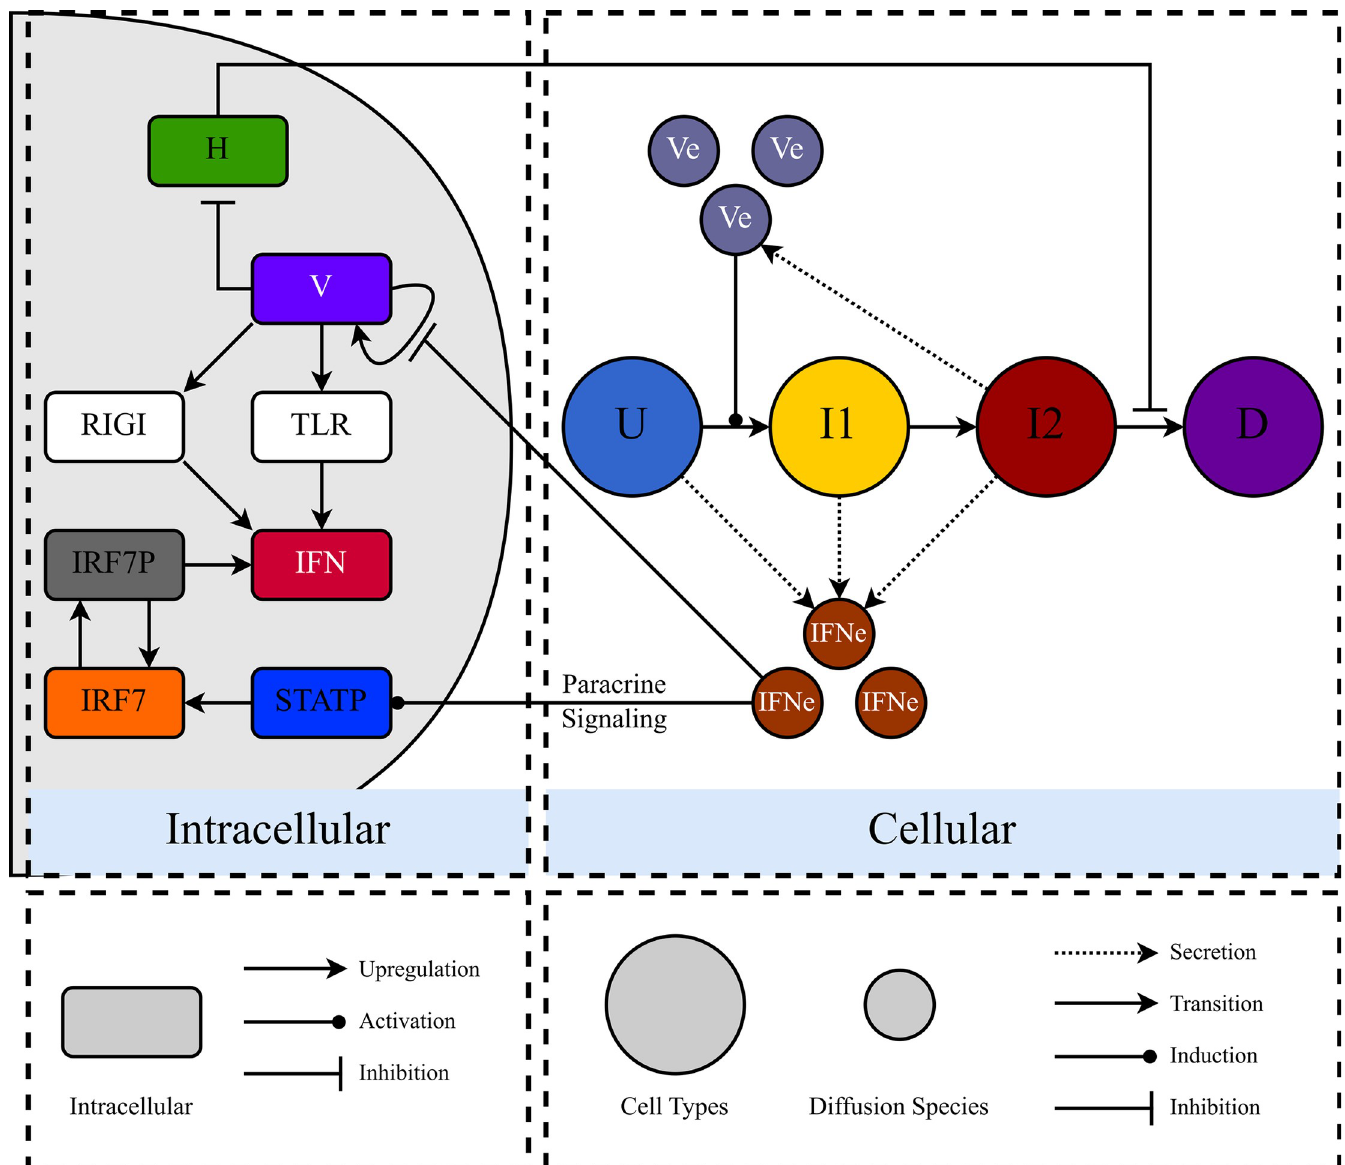
Fig 1. Conceptual diagram of the MSIS model. The MSIS model consists of an Intracellular sub-model, which describes intracellular interferon signaling during infection, and a Cellular sub-model, which defines changes in cell types and extracellular molecular diffusion. Uninfected cells (U, blue) produce IFN via paracrine signaling alone since no virus is present in these cells. Eclipse-phase cells (I1, yellow) produce IFN via viral sensor proteins (RIG-I and TLR7) and paracrine signaling (through the STAT pathway). I1 cells also export IFN into the extracellular environment. I1 cells allow virus replication but do not release virus into the extracellular environment. Virus-releasing cells (I2, red) produce IFN in a manner identical to I1 cells and export IFN and release virus into the extracellular environment. Dead (D, purple) cells do not interact with their surroundings and have no Intracellular sub-model. Cell type and chemical species colors are conserved throughout this work. Each cell contains an instance of the Intracellular sub-model representing interferon signaling (variables RIG-I, TLR, IFN, IRF7, IRF7P, and STATP), viral infection, replication, and release (V), and cell health (H). Type-I interferons (IFN e ) exported by U, I1, and I2 cells, and virus (V e ) released by I2 cells diffuse and decay in the extracellular environment. Paracrine interferon signaling occurs through the JAK/STAT pathway, indicated by the arrow from IFN e to STATP across the Intracellular/ Cellular